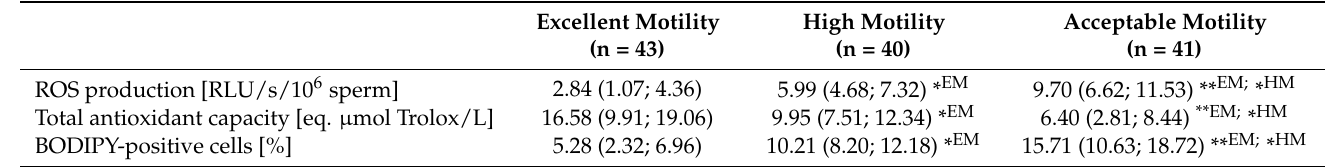
Table 2. Oxidative characteristics of semen collected from the studied groups.